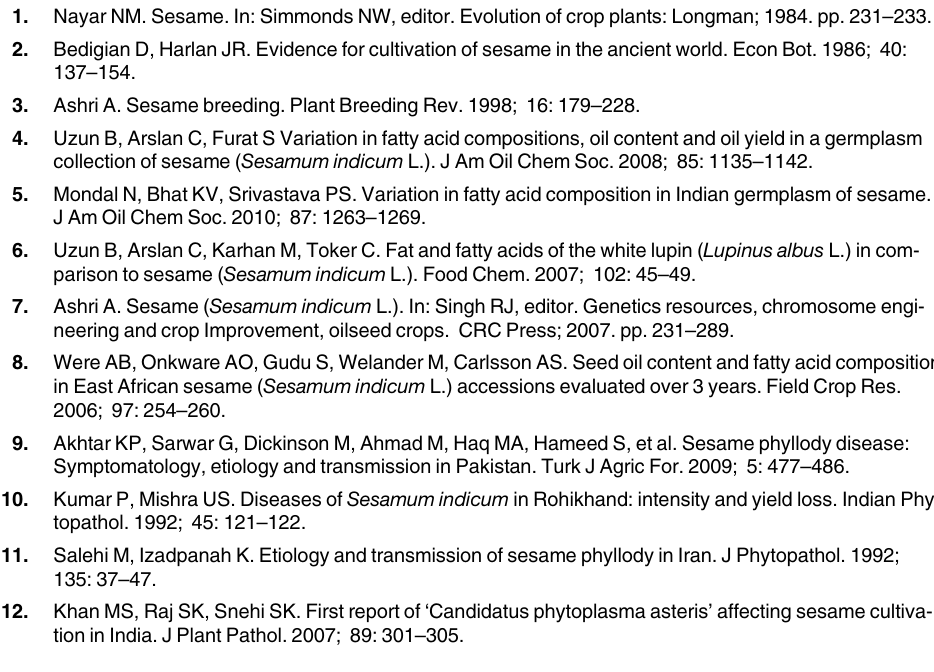
probes specific to 16SrII and 16SrIX are indicated in blue and green color, respectively. S2 Fig. SYBR 1 Green real-time PCR of six different phytoplasma groups with universal phytoplasma (A) and housekeeping (B) primers. S3 Fig. Specifity of qPCR assay on six different phytoplasma groups with universal phyto- plasma and housekeeping primers. Specific detection of 16SrII (A) and 16SrIX (B) group phy- toplasmas and housekeeping gene